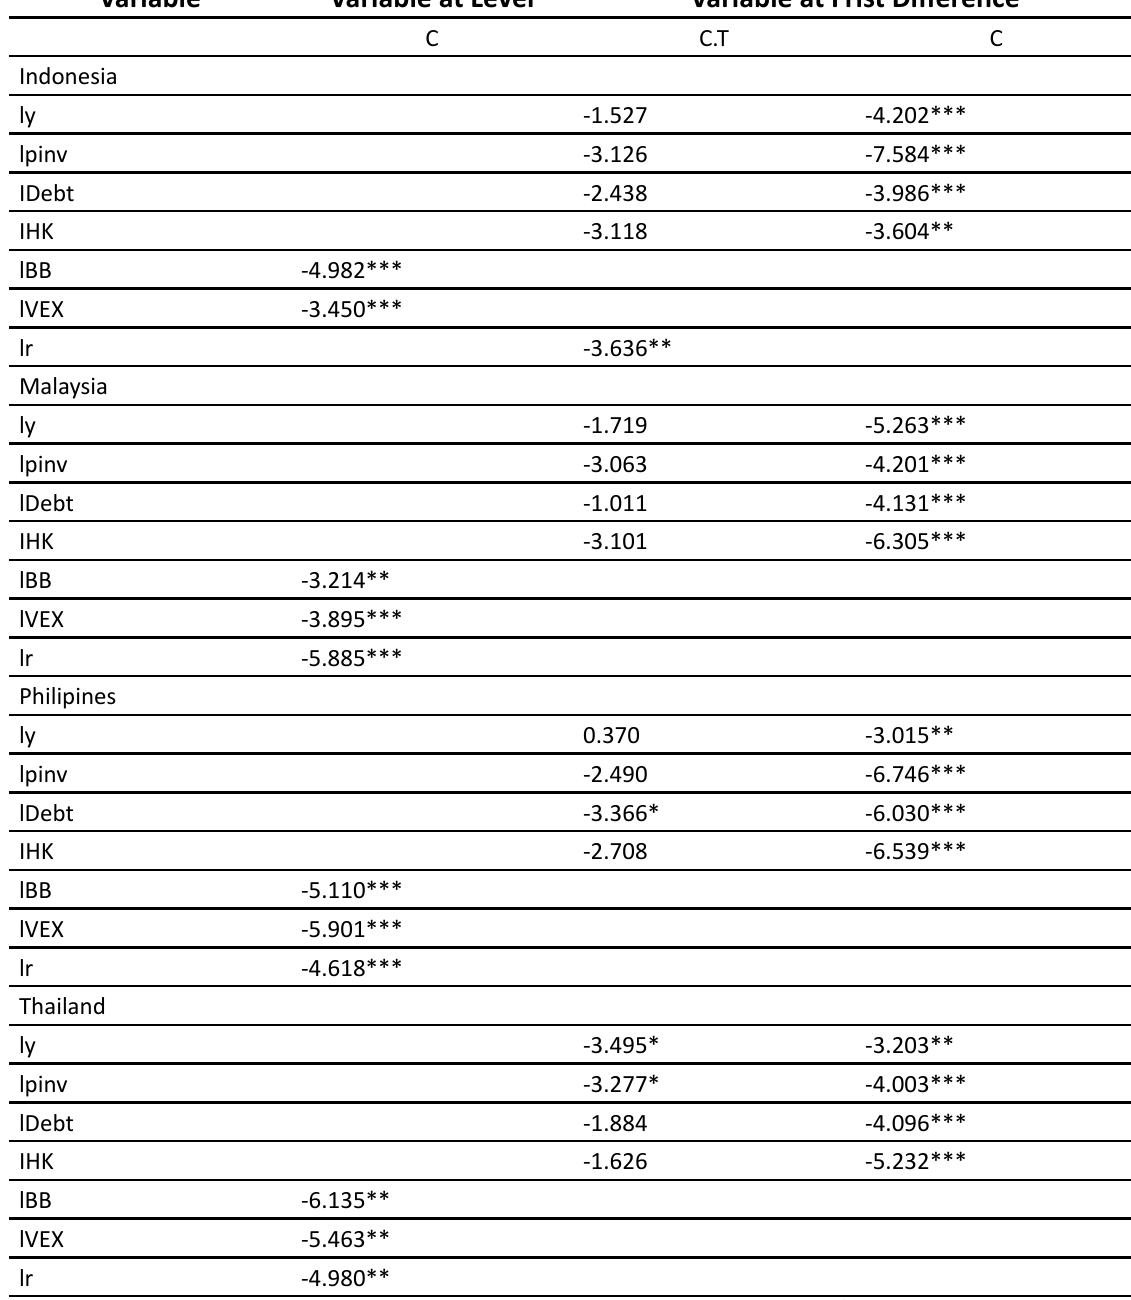
Table 2: ADF Unit Root Test Result of The Variables Included in Growth Model for ASEAN-4